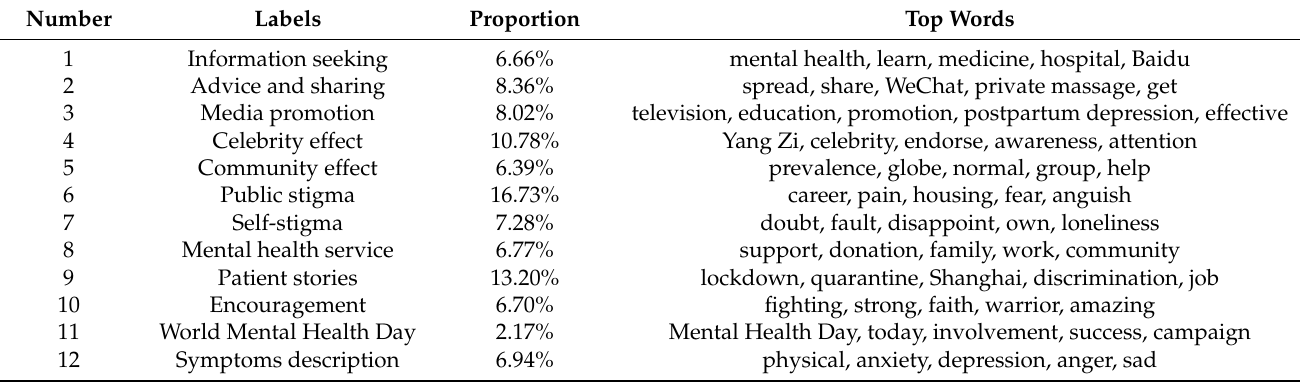
Table 1. Topics generated by